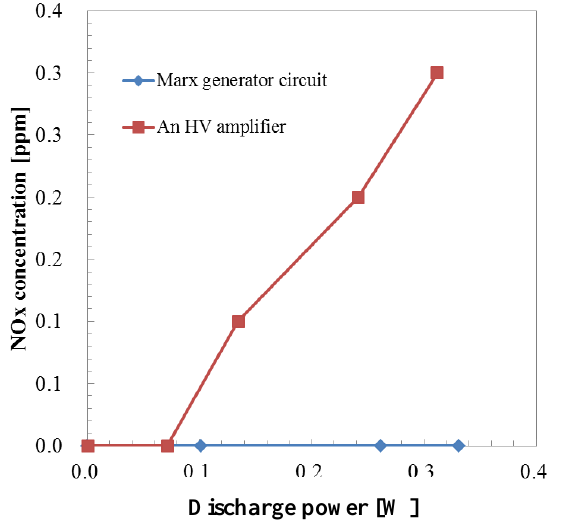
Figure 10. NOx generation by both power